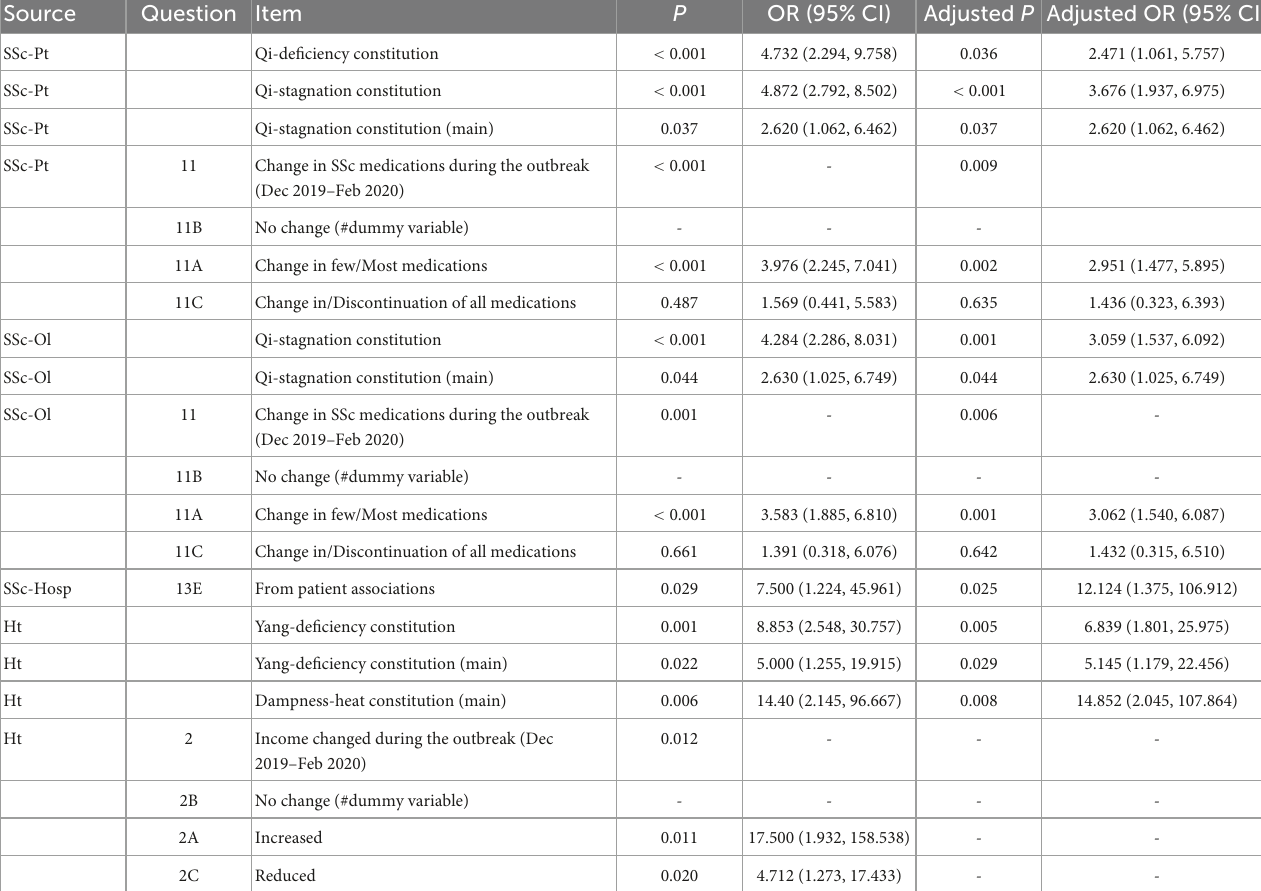
TABLE 2C Suicidal